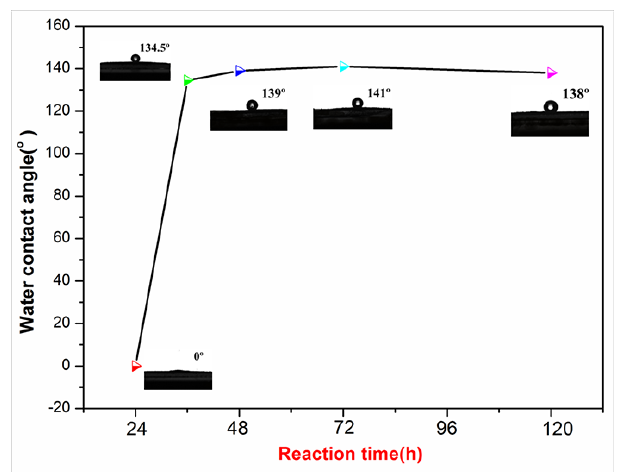
Figure 7. Effect of modifier content ratio on the WCA of C12-KH560-NCC powders. Figure 8 showed the change in the WCA of C12-KH560-NCC as a function of reaction time. It